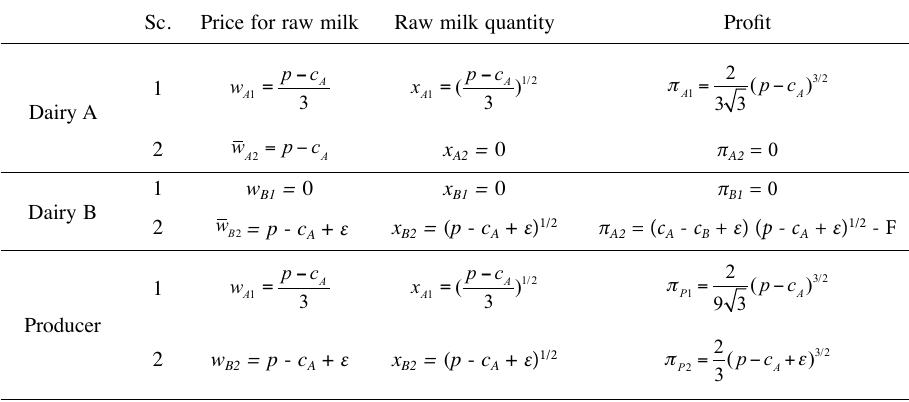
Table 1. Comparison of scenario 1 and 2.